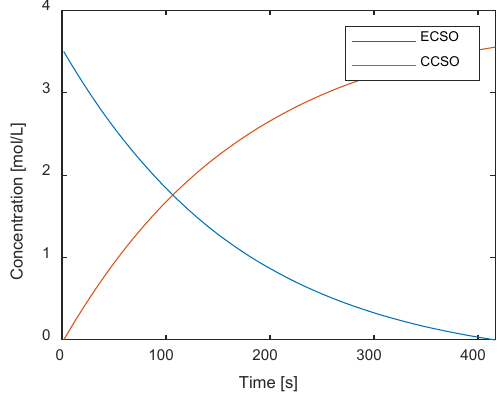
Figure 10. Integrated concentrations of ECSO and CCSO with the optimal operating parameters 383.39 K, 51.14 bar, 0.699 mol/L.